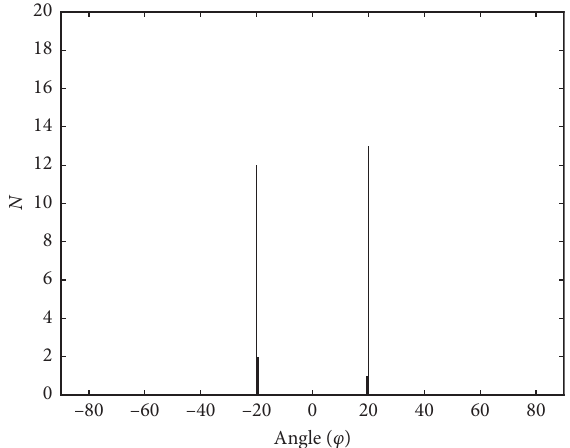
Figure 7: Count of the “worst point” (iterations � 100).